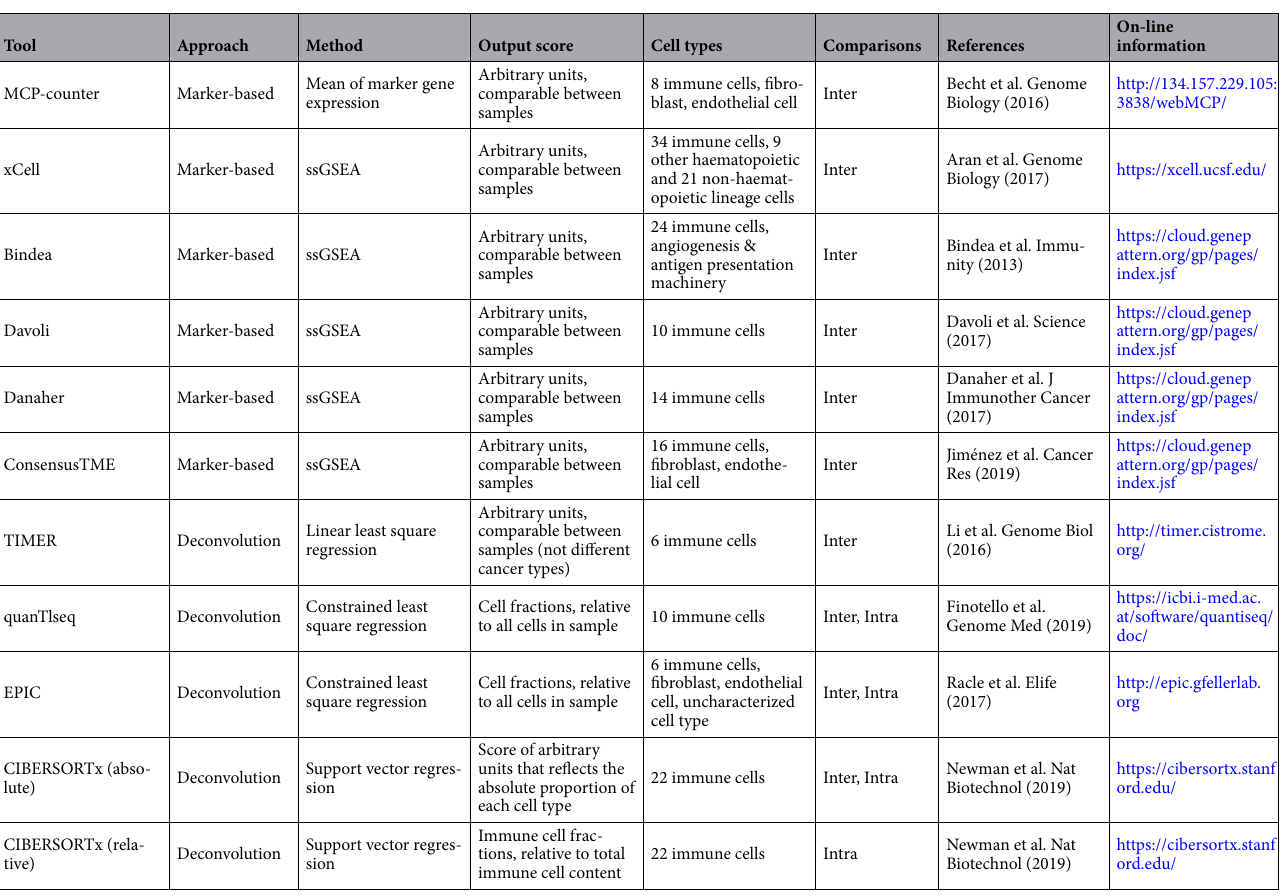
Table 2. Transcriptome-based immune cell quantification methods. ssGSEA single-sample gene set enrichment